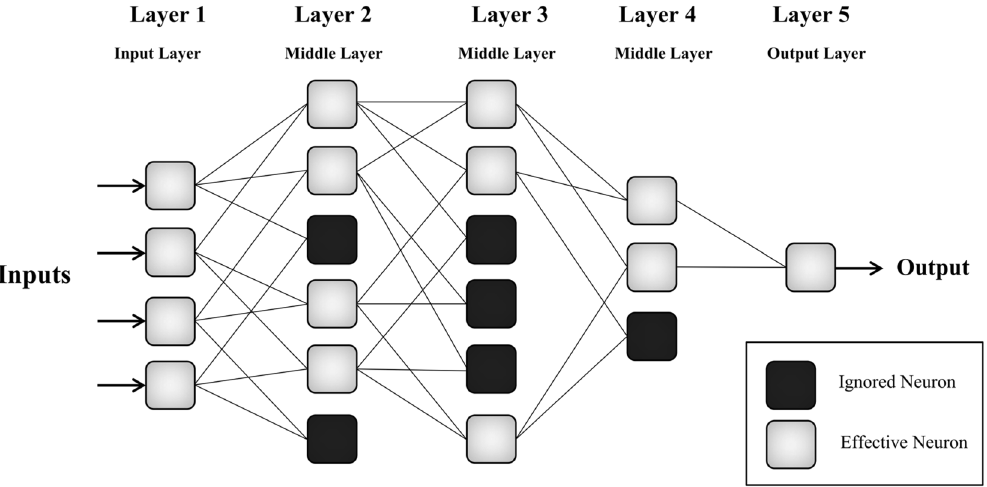
Figure 2. A schematic plot of GMDH structure with three hidden